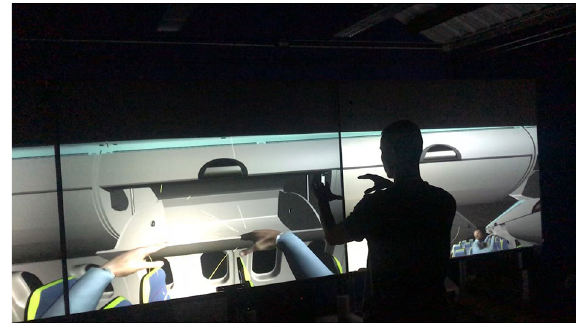
Figure 1. Interaction of the subject with the virtual cabin.